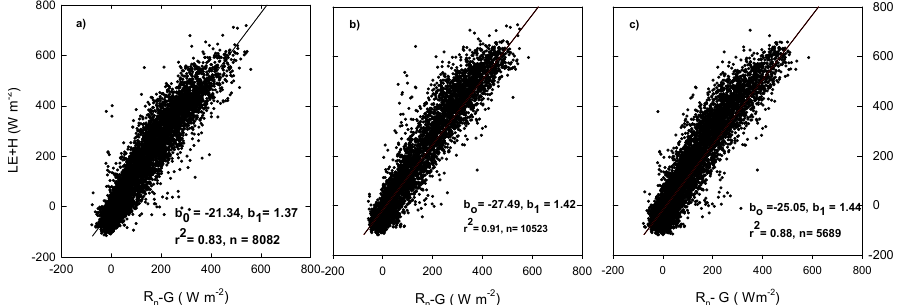
Figure 3. Energy closure at Winfred Thomas Agricultural Research Station for the measurement years of 2007 ( a ), 2008 ( b ), and 2009 ( c ). Seasonal variation in H and LE across the measurement years occurred despite that R n rates were relatively consistent, suggesting that precipitation and crop phenology were major determinants of energy partitioning (Figure 2). The fraction of H to total R n changed